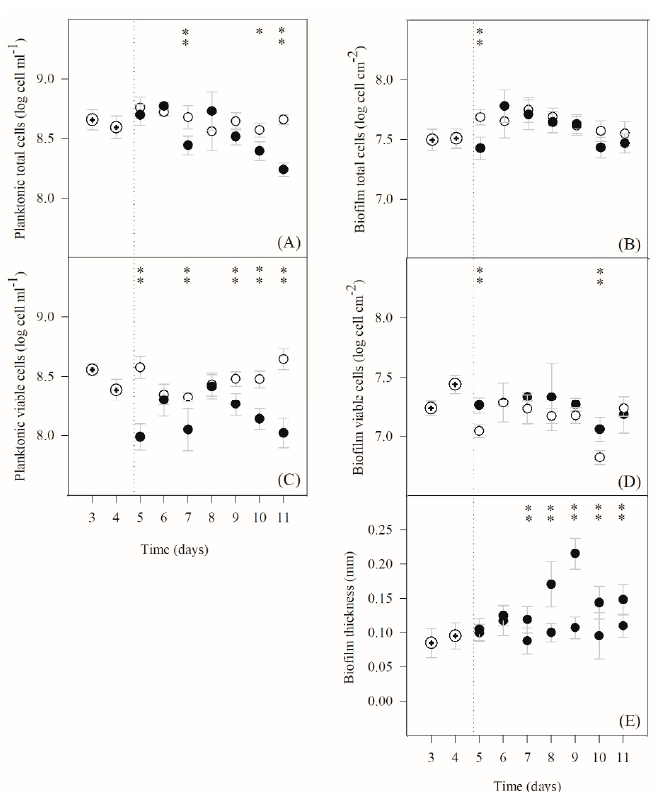
Figure 1. Time-course of planktonic and biofilm parameters: ( A ) planktonic total cells, ( B ) biofilm total cells, ( C ) planktonic viable cells, ( D ) biofilm viable cells, ( E ) biofilm thickness. Induced ( (cid:8) ) and non-induced ( ) LB culture. The dotted lines indicate the day on which the culture was induced with 2 mM isopropyl β -D-1-thiogalactopyranoside (IPTG). The biofilm and planktonic samples corresponding to day 5 were collected 6 h after IPTG addition. Results are an average of three independent experiments for each condition, except in days 3 and 4 that result from an average of six independent experiments (three experiments for induced conditions and three experiments for non-induced conditions ( )). The averages ± SDs (indicated as bars) are illustrated. Statistical analysis corresponding to each time point is represented with ∗ for a confidence level greater than 90% ( p < 0.1) and with ∗ ∗ for a confidence level greater than 95% ( p < 0.05).